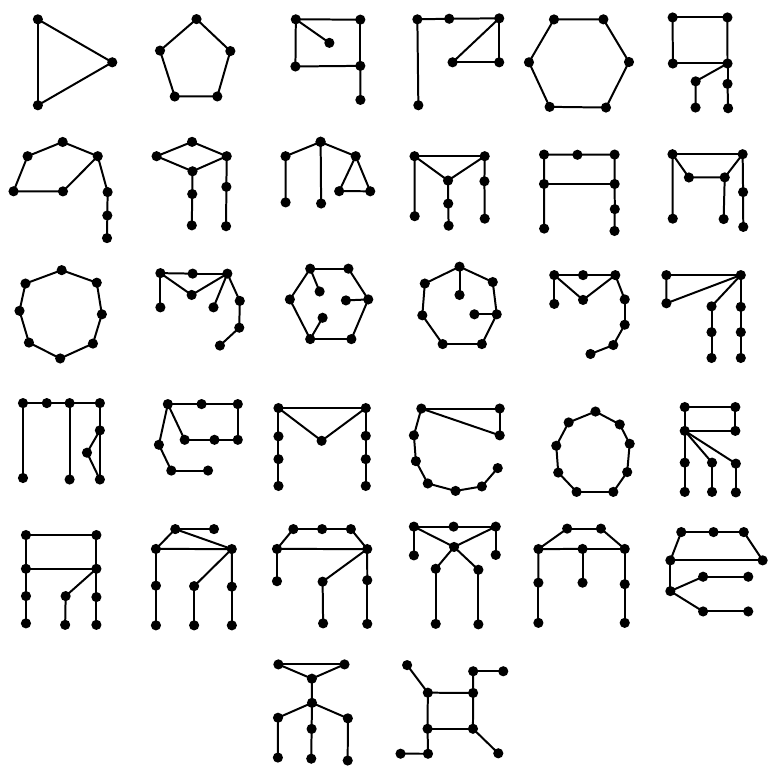
Figure A2. All independent domination stable unicyclic graphs of orders from 3 to